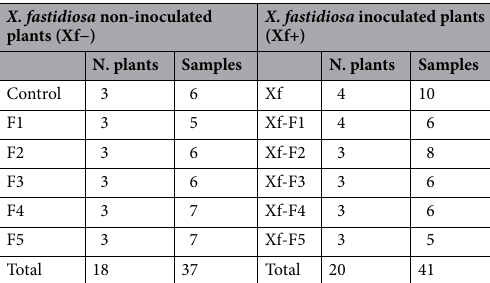
Table 1. Features of the olive plants under